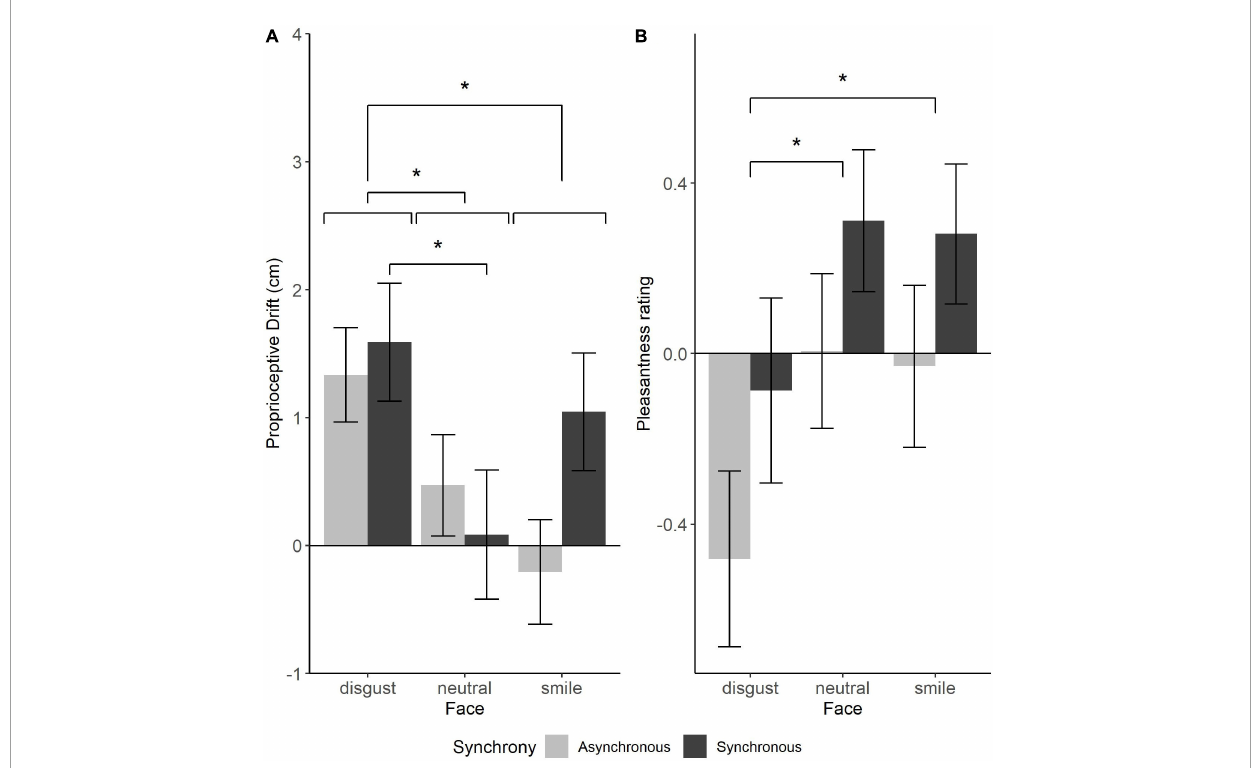
FIGURE3 (A) Proprioceptive drift (cm). (B) Standard scores of pleasantness. Dark and light bars represent synchronous and asynchronous stroking conditions, respectively, averaged across participants. Error bars show standard errors of mean. * p < 0.05.